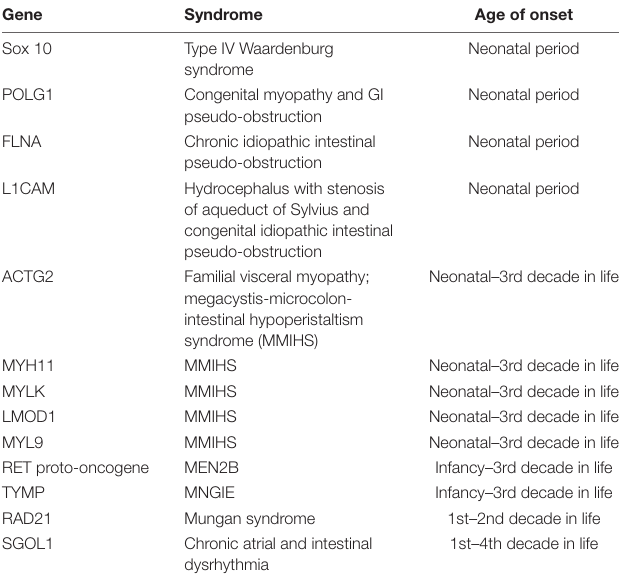
TABLE 1 | Monogenic mutations associated with Pediatric Intestinal